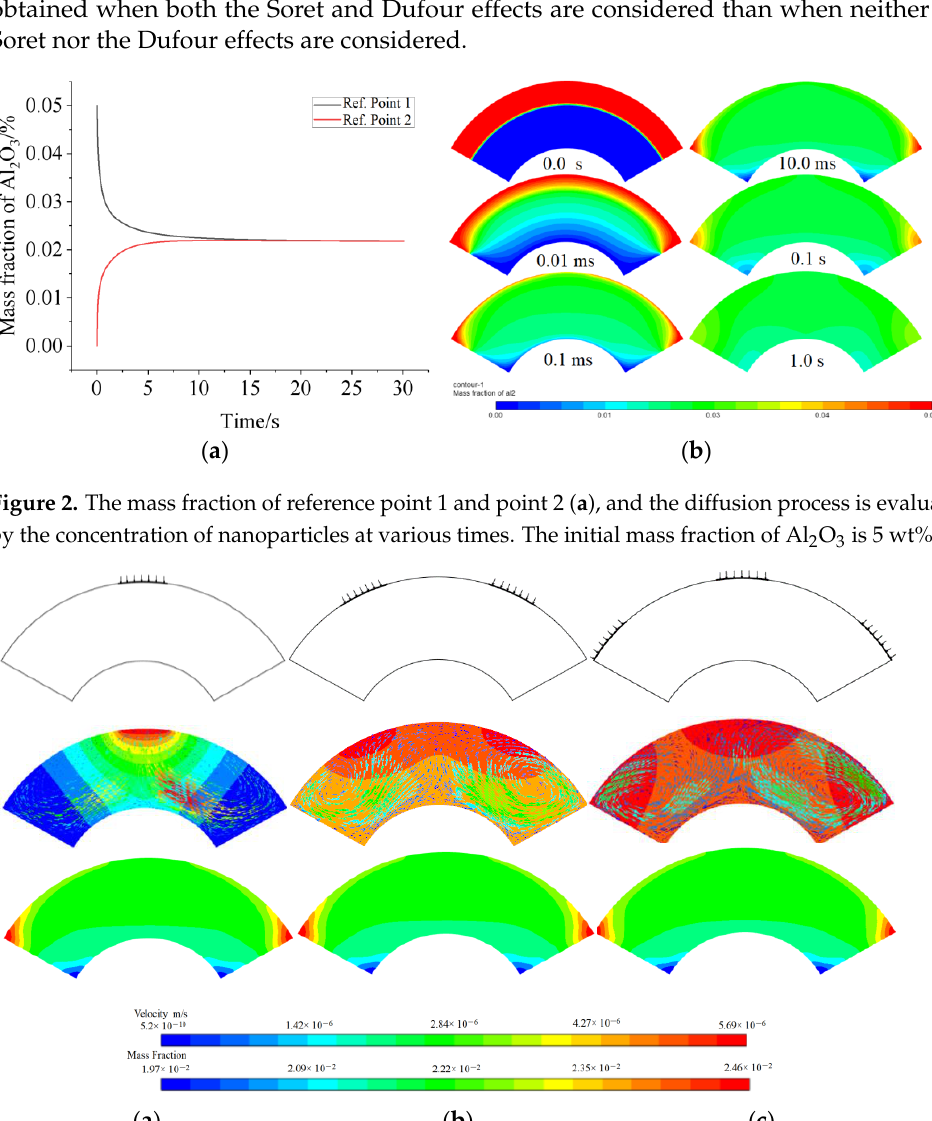
Figure 3. The heat sources (first row), temperatures and flows (second row), mass fraction fields (third row) 3 s after the heat sources were loaded. ( a ) one heat source on the middle top, ( b ) two symmetry heat sources on the top, ( c ) three heat sources on the top. The temperature of heat sources is 350 K, the initial mass fraction of nanoparticle is 5 wt%.